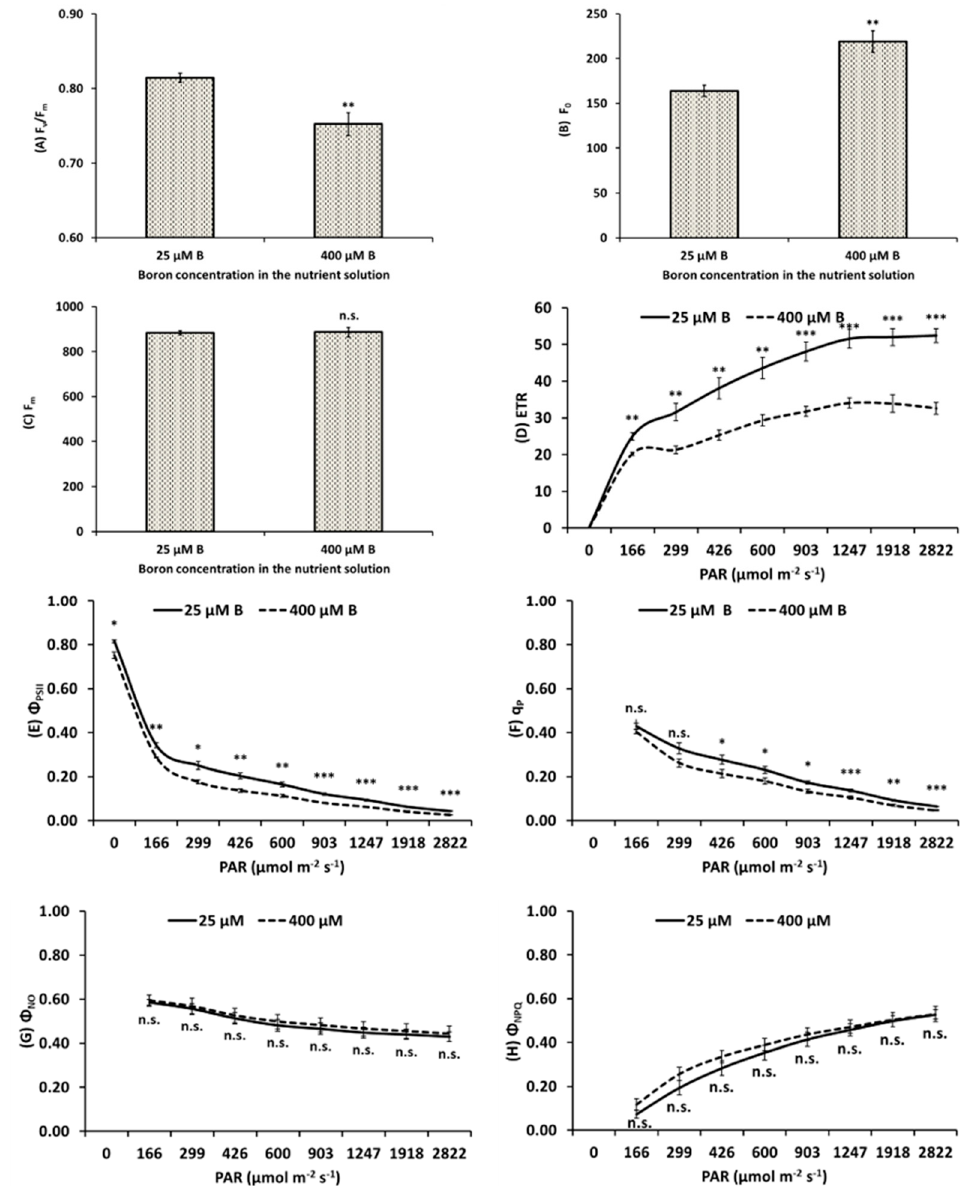
Figure 3. Chlorophyll a fluorescence parameters (mean ± S.E.) derived from the rapid light curves measurements at different Photosynthetic Active Radiation (PAR) intensities, ranging from 0 to 2800 μ mol photons m − 2 s − 1 , that were carried out in top leaves of apple plants treated with either 25 (control) or 400 μΜ Β (B excess): Maximal photosystem II (PSII) photochemical efficiency F v / F m ( A ), minimal level of fluorescence F 0 ( B ), maximum level of fluorescence F m ( C ), electron transport rate electron transport rate (ETR) ( D ), operating PSII efficiency, Φ PSII ( E ), photochemical quenching of PSII, q p ( F ), quantum yield of non-regulated ( Φ NO ) ( G ) or regulated ( Φ NPQ ) ( H ) photochemical energy loss. Mean ± S.E., n = 8; each replicate ( n ) corresponds to a different plant per B treatment. *, **, *** Significant differences at p < 0.05, p < 0.01 or p < 0.001, respectively; n.s., non-significant differences.